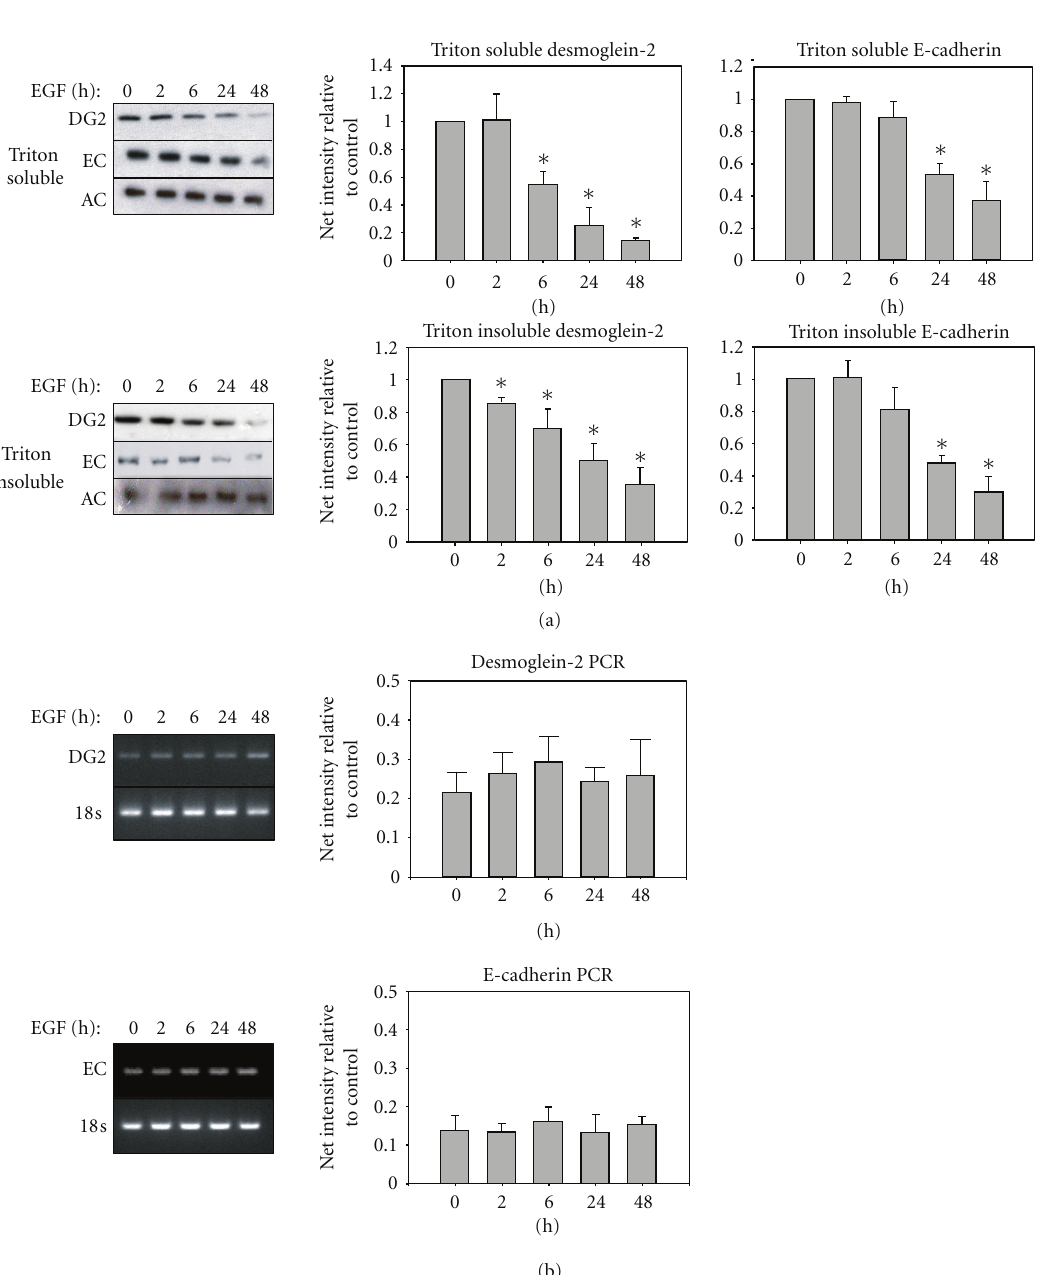
Figure 3: EGF regulation of cadherin proteins in membrane and cytoskeleton-associated pools. Cells were grown to subconfluence, placed in serum-free medium overnight, and then treated with EGF for the indicated times. DG2: desmoglein-2, EC: E-cadherin, AC: alpha-catenin. (a) Sequential detergent extraction separates the triton soluble (membrane-associated) fraction, from the triton insoluble, (cytoskeletal, or intact junctional) fraction. Blots are representative of a minimum of three separate experiments. Bar graphs represent the densitometric quantification of each lane normalized to no treatment control, with asterisks indicating statistical significance. ( P < 0 . 05) (b) Cells were treated with or without EGF for the indicated times, and mRNA level was measured by PCR. Bar graphs represent the densitometric quantification of bands normalized to no treatment